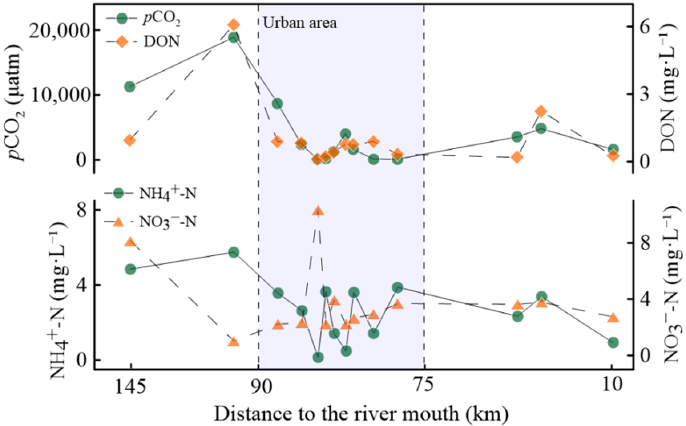
Figure 7. Longitudinal variations in p CO 2 concentrations and nitrogen concentrations along the Haihe River.